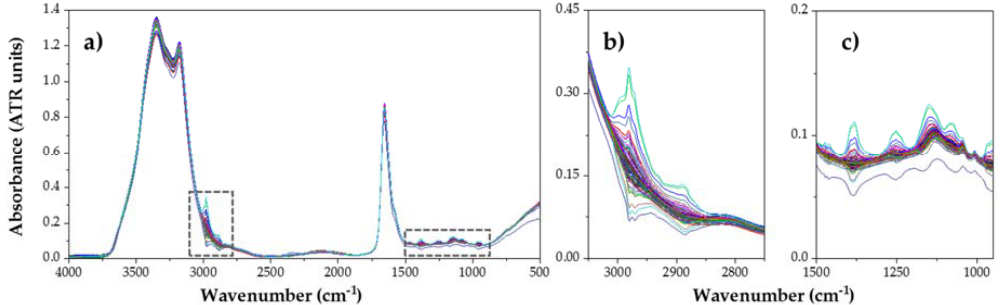
Figure 2. ( a ) ATR MIR spectra (Attenuated Total Reflectance ‐ Fourier Transform Mid ‐ Infrared Spectroscopy) of L_OX (lipid oxidation) samples (240 analyses) and expanded areas of interest: ( b ); 2800–3100 cm − 1 . ( c ) 1525–1750 cm − 1 .